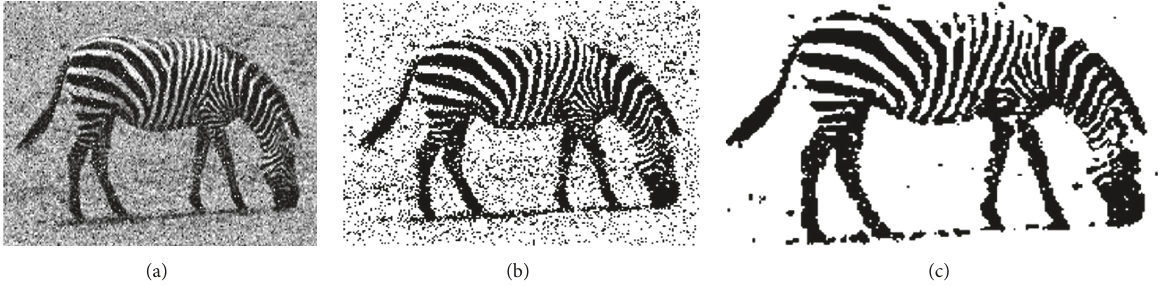
Figure 10: Horse image (mixed mean of Gaussian noise is 0 and variance is 0.02 and 0.02-degree encryption salt and pepper noise). (a) Original. (b) The results of one-dimensional Otsu method. (c) The results of our